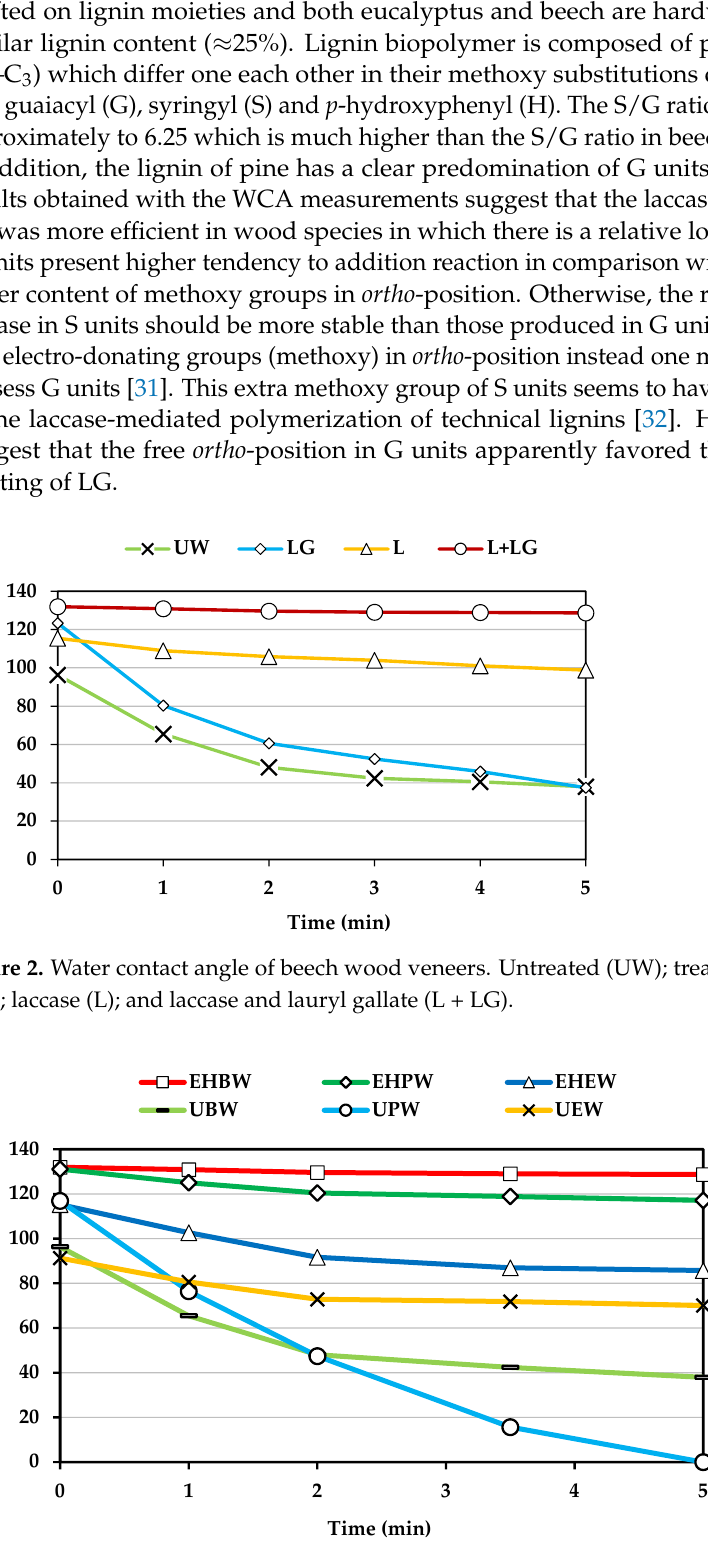
Figure 3. Water contact angle of wood veneers. Enzymatically hydrophobized beech wood (EHBW); pine wood (EHPW); and eucalyptus wood (EHEW). Untreated beech wood (UBW); pine wood (UPW); and eucalyptus wood (UEW).